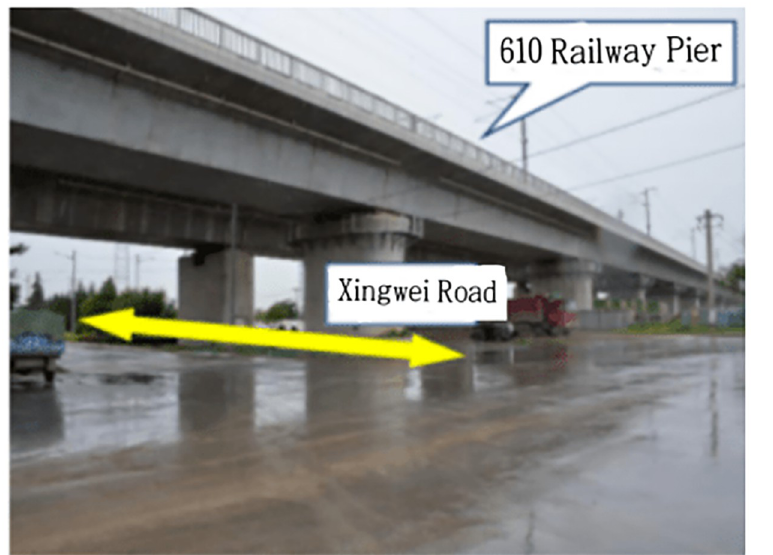
Fig 1. Overview of the construction